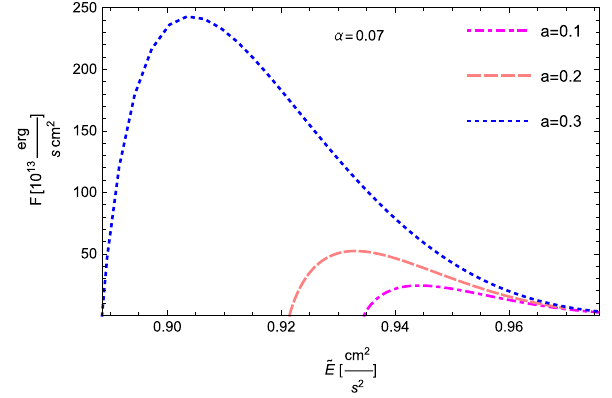
Fig. 7 The emitted flux as a function of the energy for a rotating BH in 4 D EGB gravity. The GB coupling parameter is set to α = 0 . 07